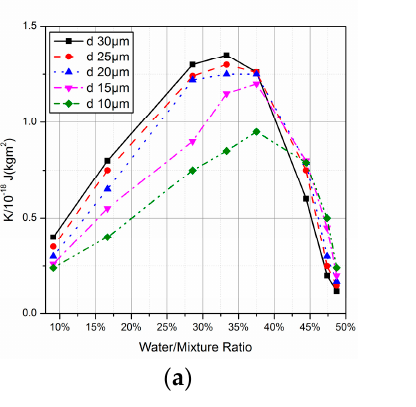
Figure 5. Effect on the strength of micro-explosions: ( a ) water content in the emulsion; ( b ) diameter of the water droplets; ( c ) initial droplet size of the emulsion (adopted from [82]).